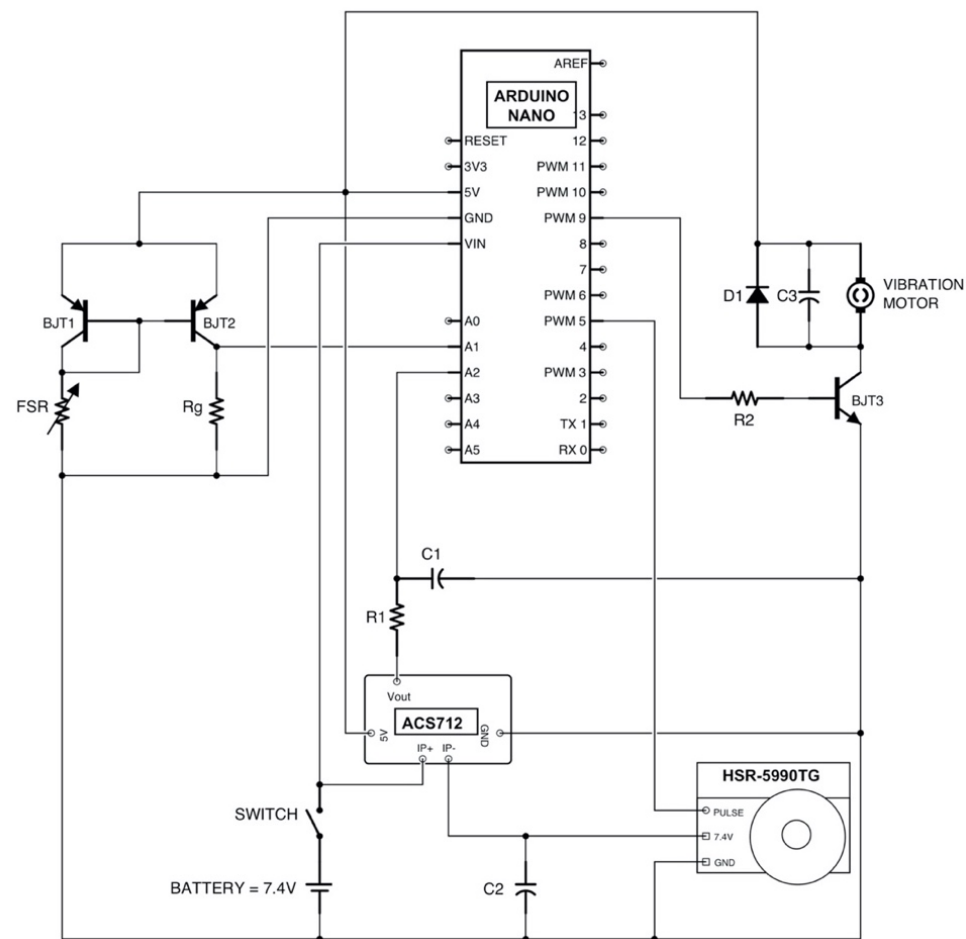
Figure 8. Circuit diagram based on Arduino platform (R G = 910 Ω ; R 1 = 1.6 K Ω ; C 1 = 20 μ F; C 2 = 0.47 mF, D 1 (1N4001); R 2 = 1K Ω ; C 3 = 0.1 μ F).